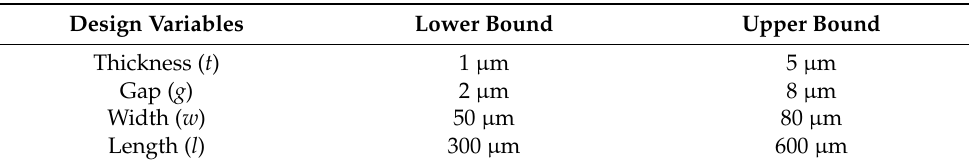
Table 3. Design variables for RF-MEMS switch.